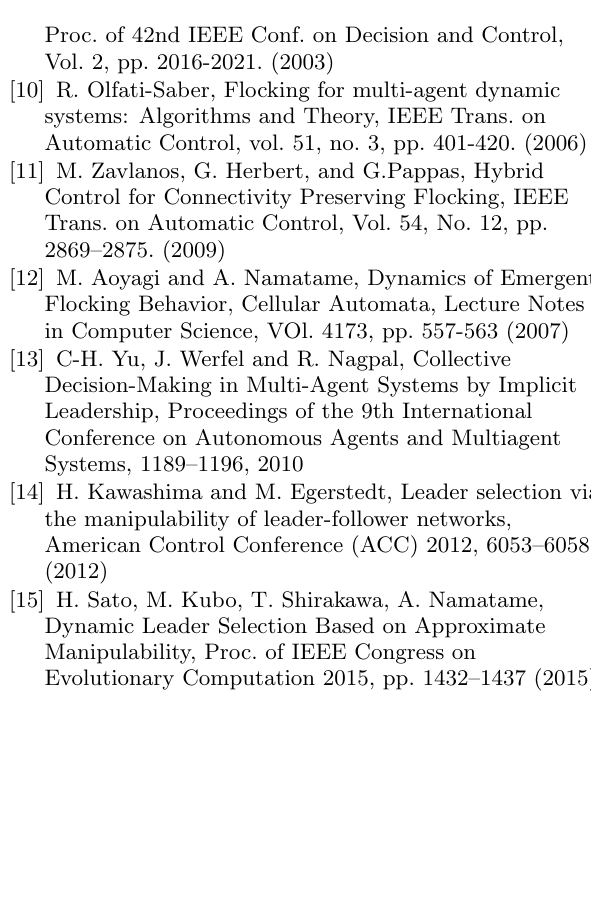
Figure 2: The time required to reach the tar- get. Solid line: Local leader selection, Dashed line: Global leader selection, Dotted Line: Random leader selection.